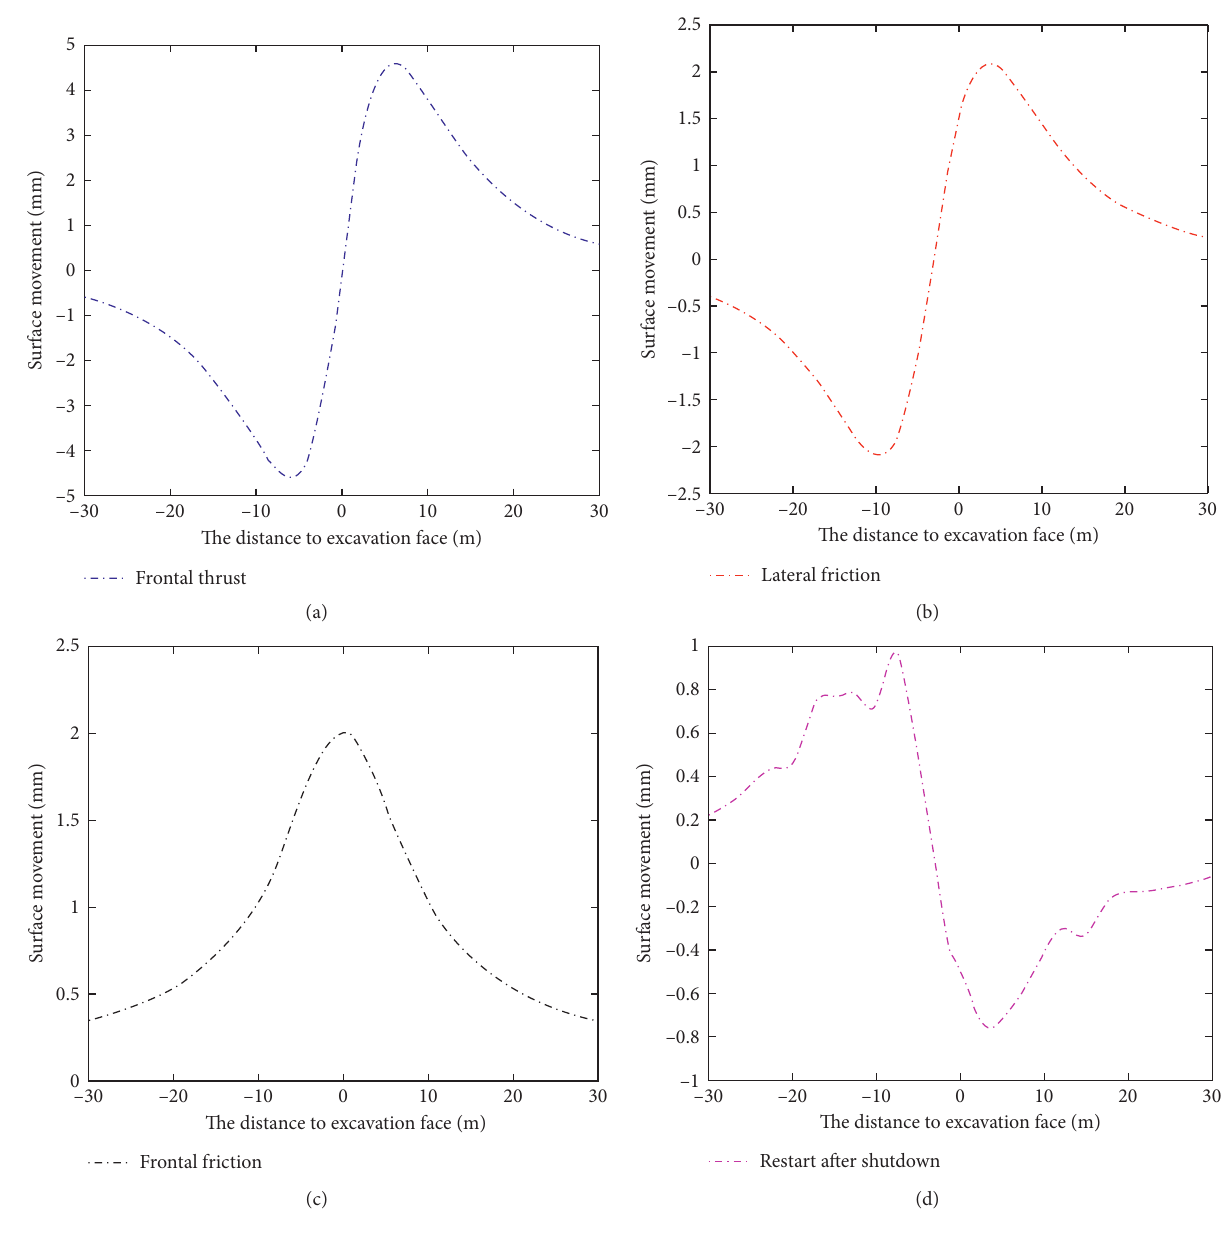
Figure 7: Surface deformation curves caused by various factors, (a) frontal additional pressure, (b) uneven lateral friction, (c) frontal friction generated by the shield cutterhead, and (d) shield machine restart after